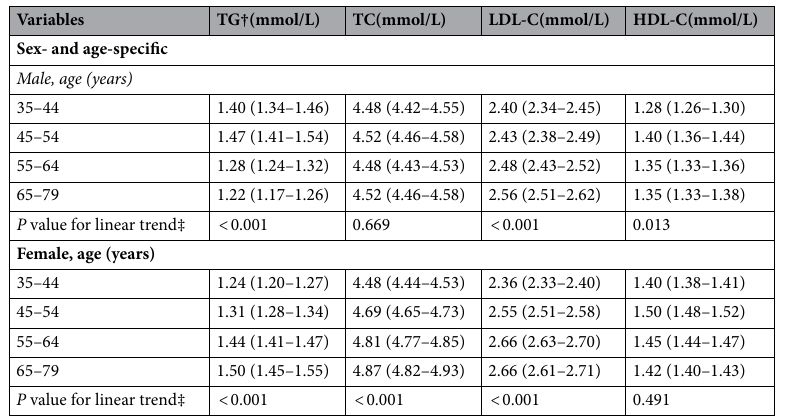
Table 2. Sex- and age-specific mean (95% confidence interval) of serum total cholesterol, HDL cholesterol, LDL cholesterol, and triglycerides levels among adults aged ≥ 35 years in Southwestern China. TG, triglyceride; TC, total cholesterol; LDL-C, low density lipoprotein cholesterol; HDL-C, high density lipoprotein cholesterol. † Serum triglyceride measurements have a right-skewed distribution, so geometric mean and 95% confidence interval are calculated. ‡ P value from linear